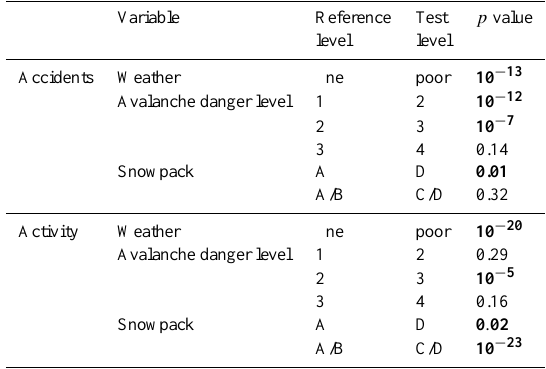
Table 3. p values for the Fisher exact test testing equality of pro- portions of the expected and observed frequencies as shown in Ta- ble 1 (base rate vs. rate of accidents or activity). p values ≤ 0.05 are shown in